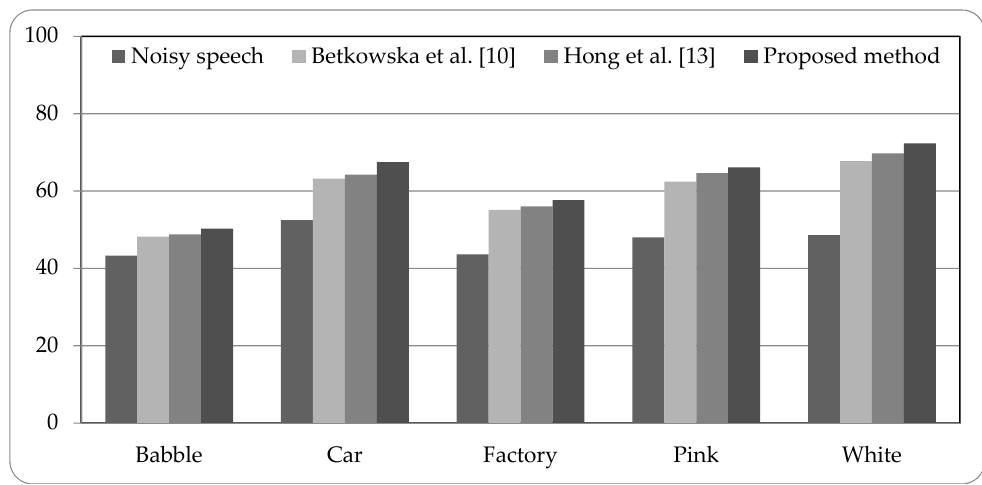
Figure 7. Speech recognition rates of noisy speech (10 dB), related works, and proposed method.